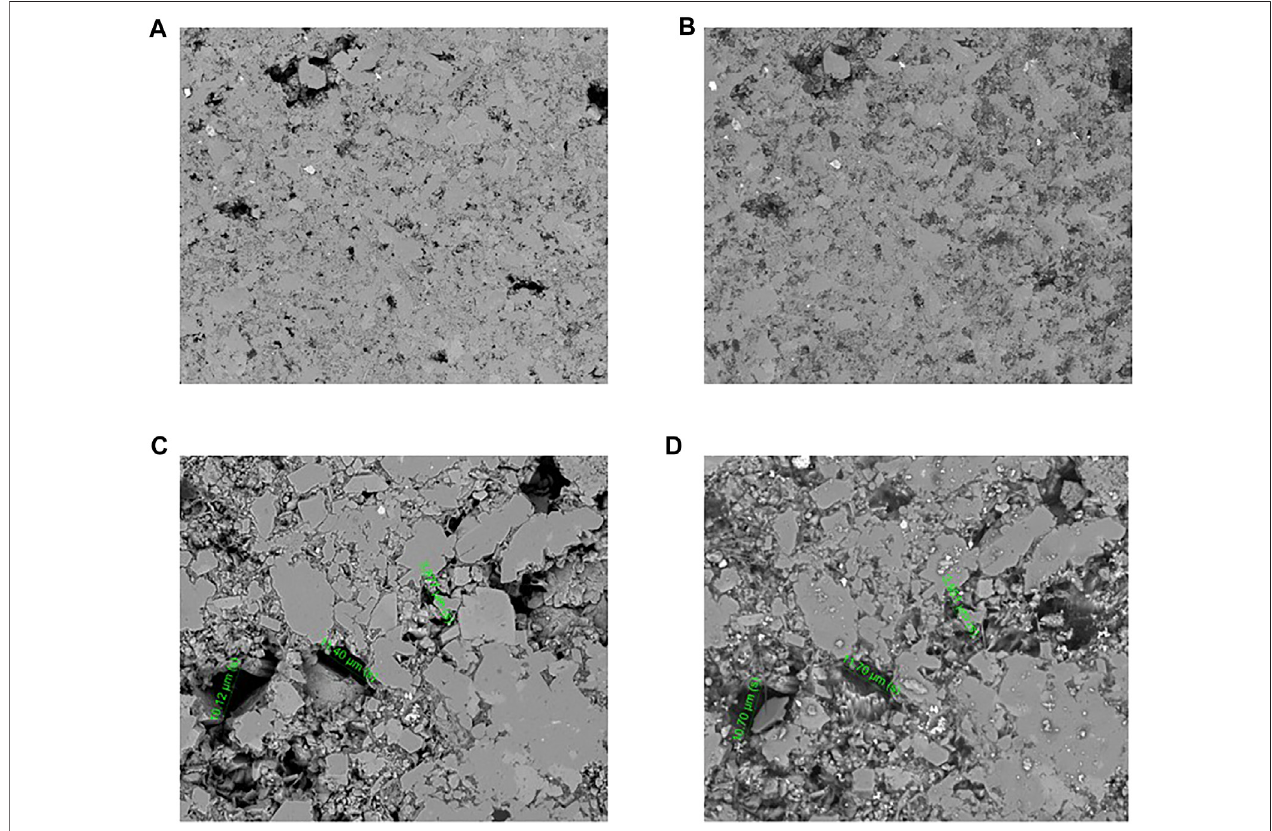
FIGURE 10 | The pore structure before and after soaking with pure CO 2 : (A) Before soaking; (B) After soaking; (C) Enlarged view of a typical position before soaking; (D) Enlarged view of a typical position after soaking.